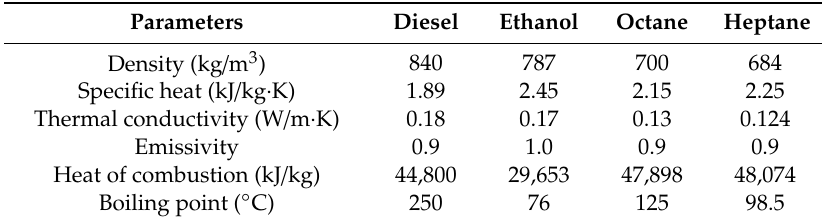
Table 2. Properties of combustion materials considered in this study.